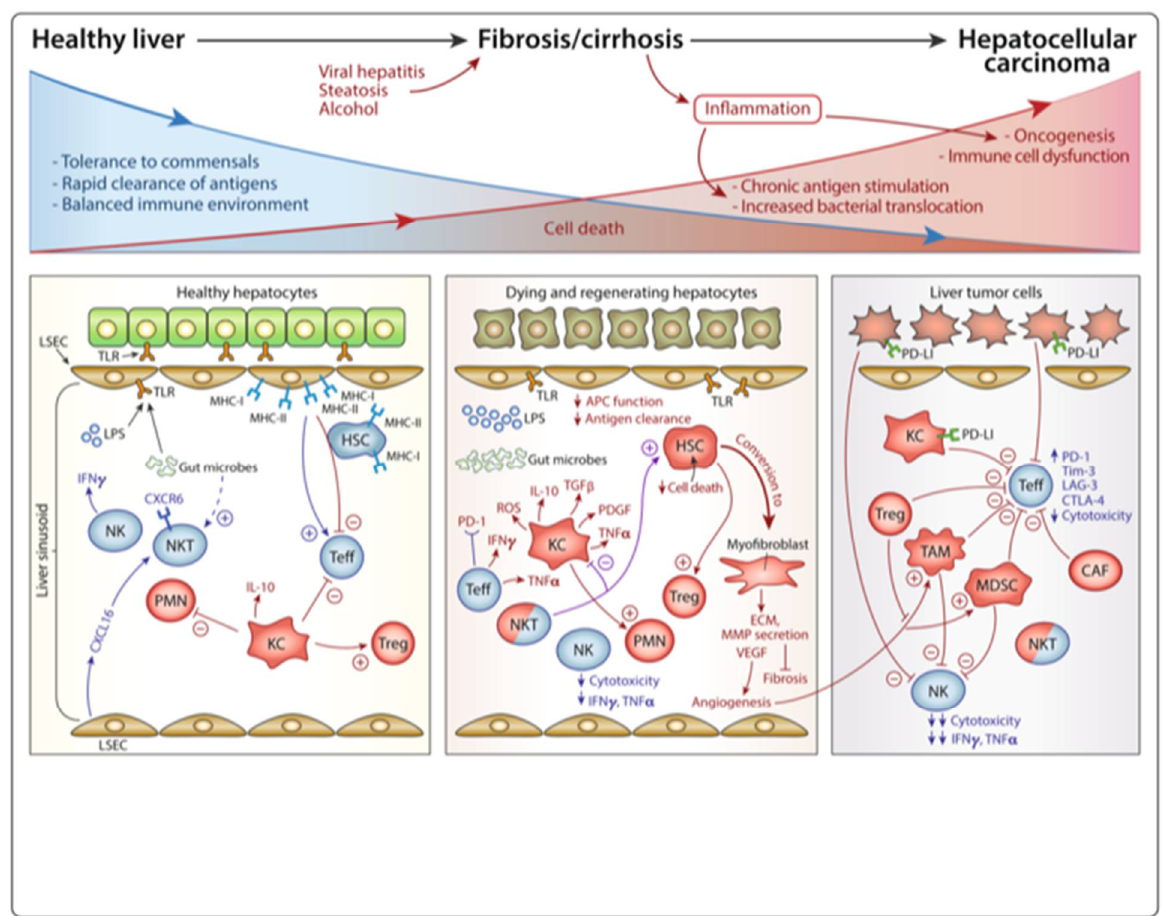
Figure 2. Liver immunobiology across a spectrum from healthy liver to inflammation and oncogenesis.